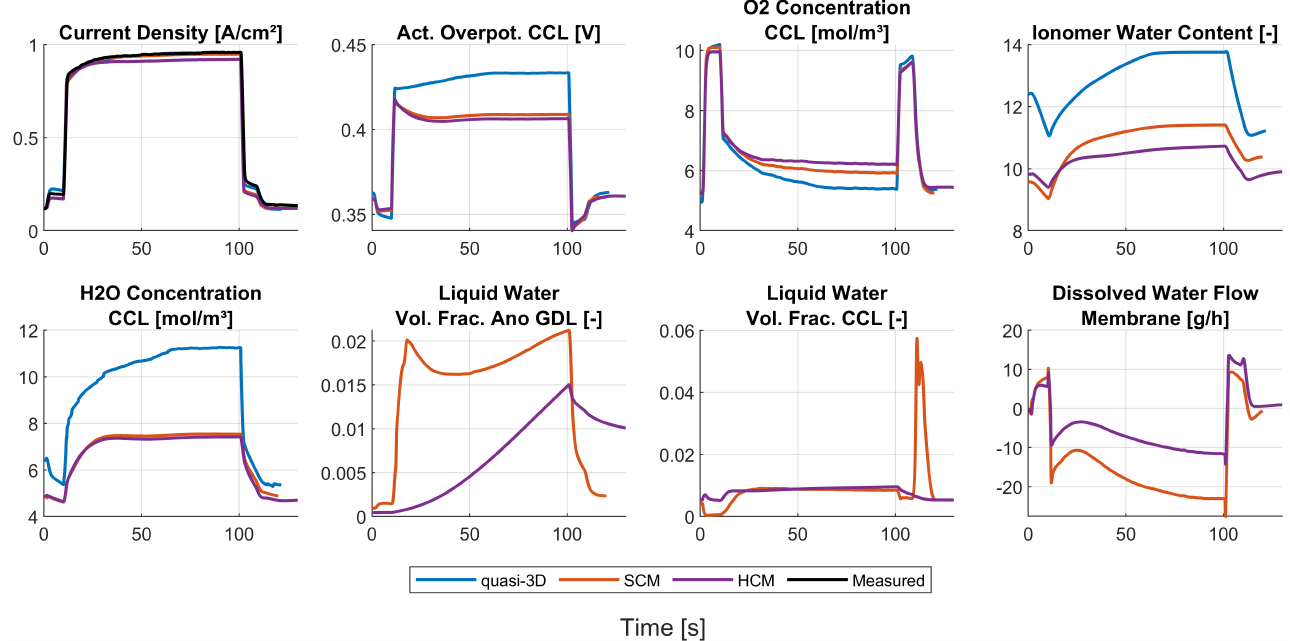
Figure 9. Simulation results from load step L3 with three different models: quasi-3D, SCM, and HCM. Current density was well predicted by all three models. Differences occurred in the activation overpotential of the CCL and the water-related